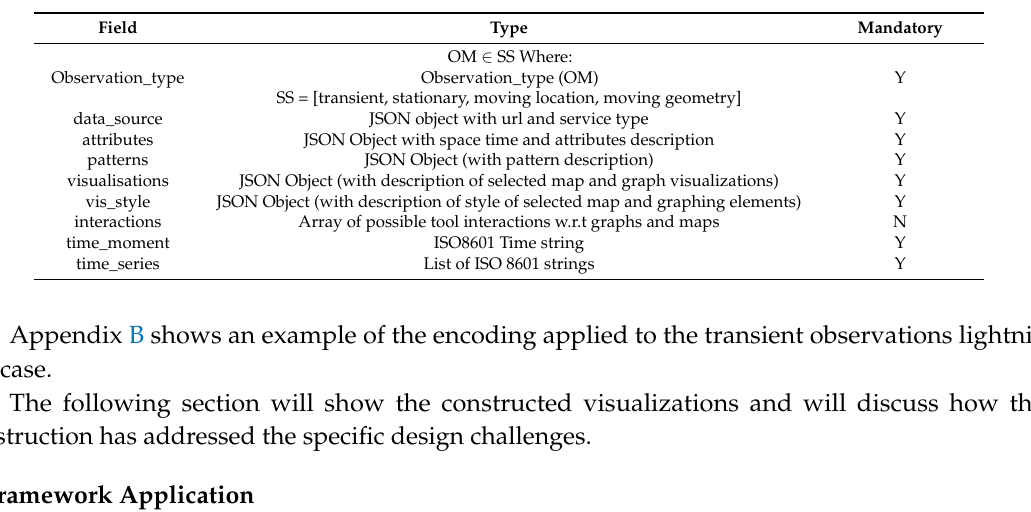
Table 5. Important elements of the encoding for the